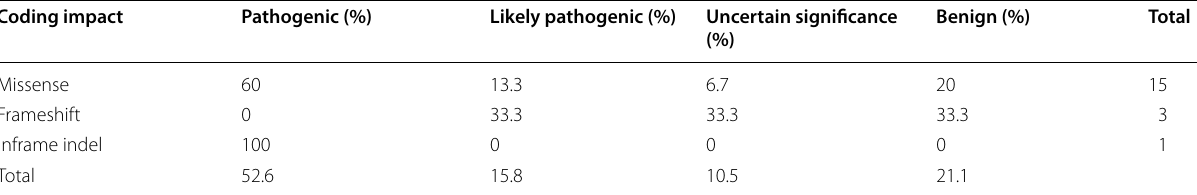
Table 1 Total classified variants in FAM111B gene (UniProt, ClinVar, VarSome & PubMed) Coding